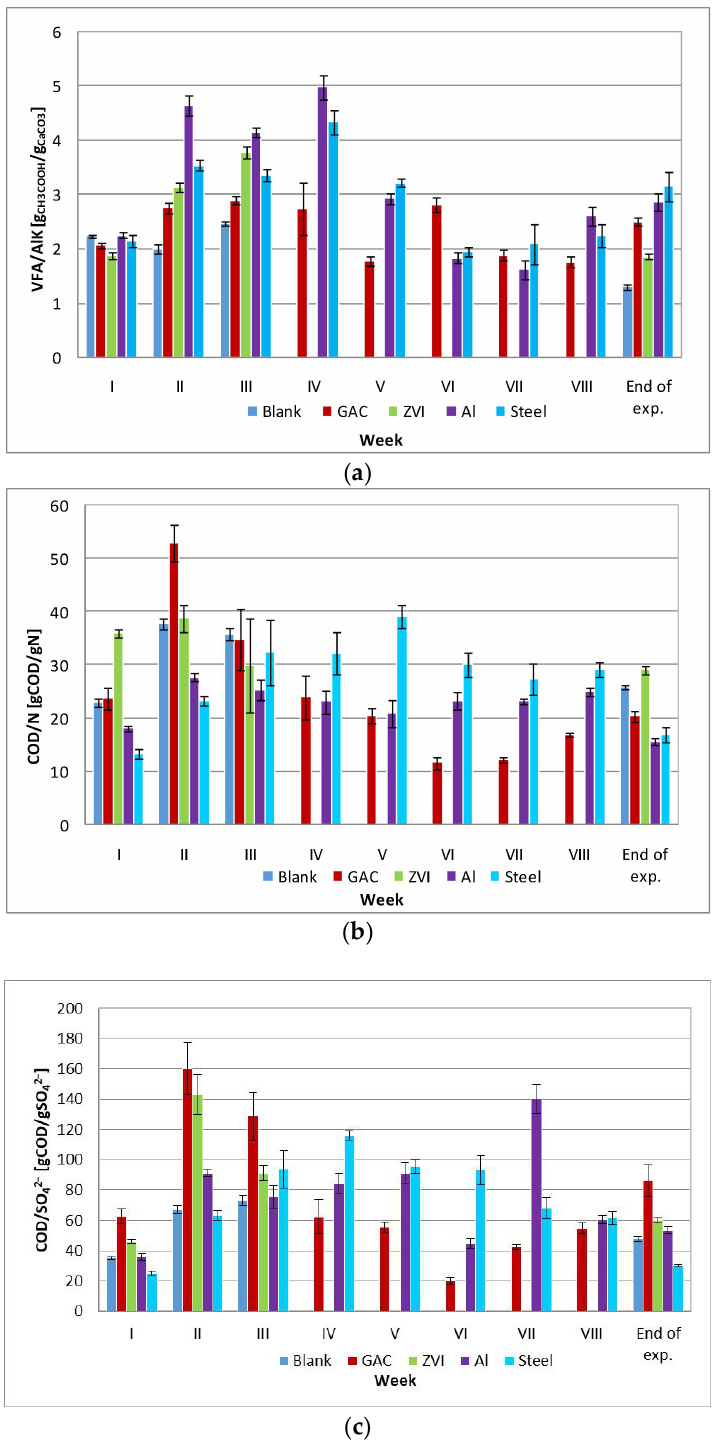
Figure 6. VFA/ALK ( a ), COD/N ( b ), and COD/SO 42− ( c ) ratios in semi-continuous tests (lacking data refer to periods where feeding was not performed and, therefore, digestate was not extracted).